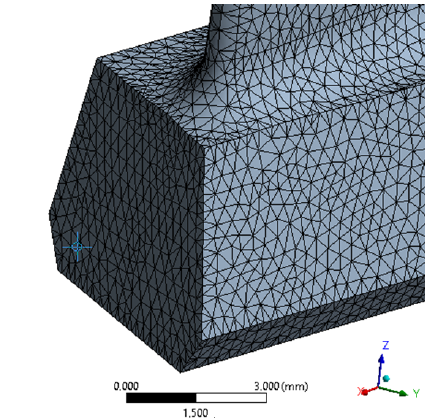
Figure 6. Discrete model for strength